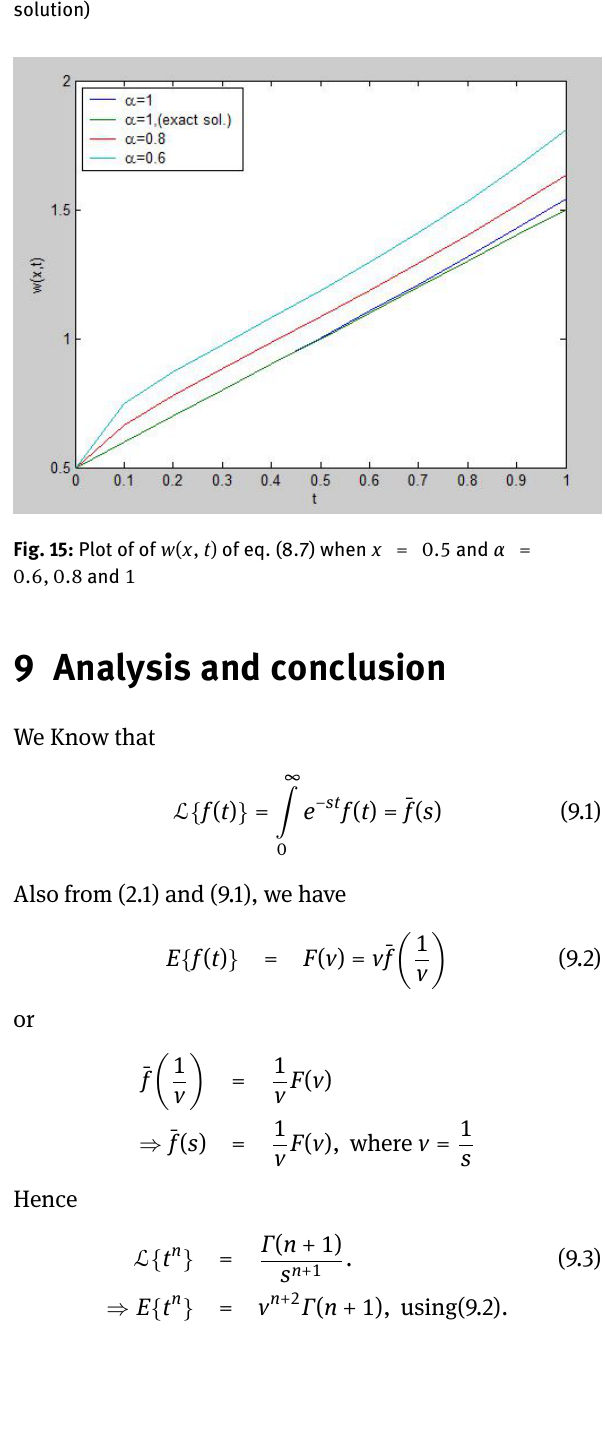
Fig. 14: Surface graph of w ( x , t ) of eq. (8.7), when α = 1 (exact